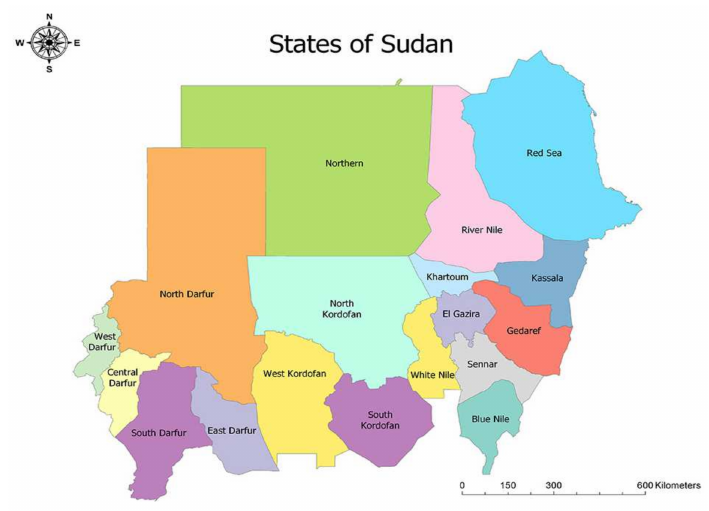
Figure 7. Different states of Sudan